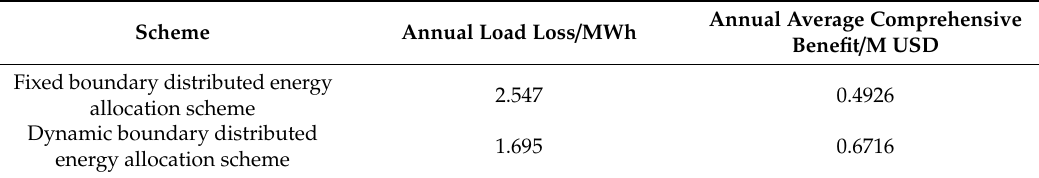
Annual load loss and comprehensive benefit comparison of the distributed energy allocation